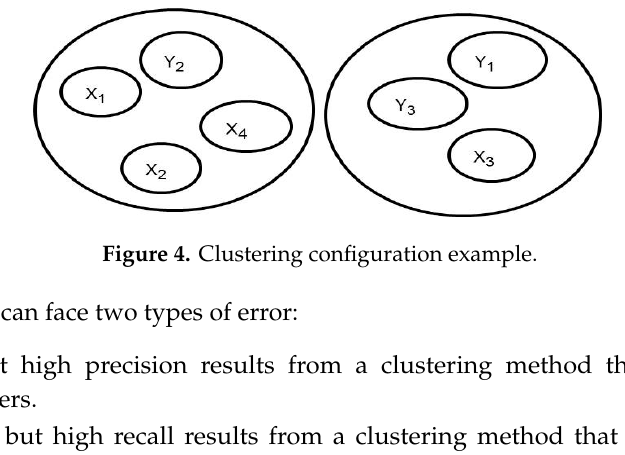
Figure 5. Face images in FaceScrub dataset. 4.1.2. The LFW Dataset